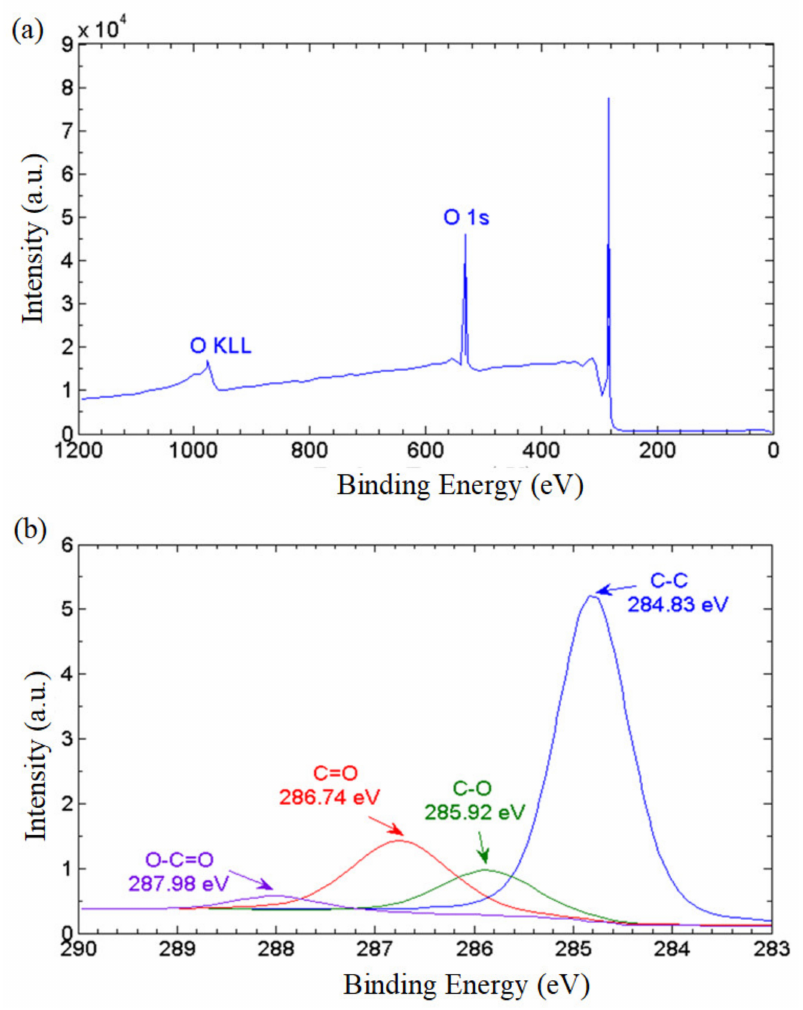
Figure 6. ( a ) XPS survey spectrum, and ( b ) XPS carbon (C1) spectra of the thermally cured